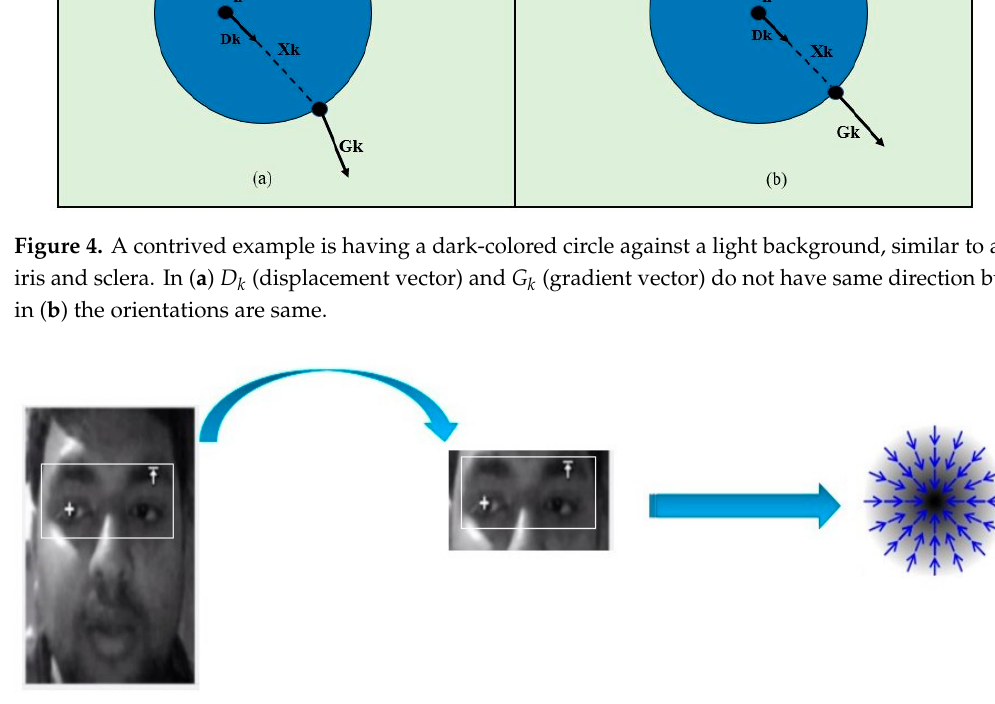
Figure 5. Eye core located ( left ) indicated with white mark in the presented system, using image gradients symbolically directed towards the center ( Right ).